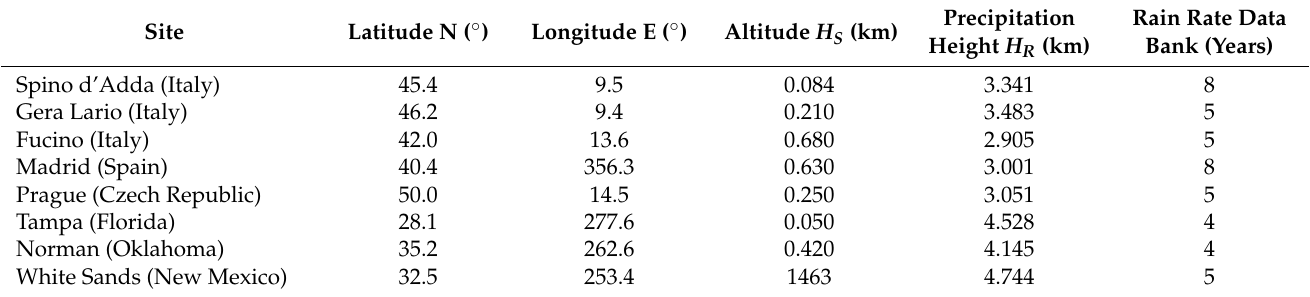
Table 1. Geographical coordinates, altitude (km), rain height H R (km), and number of years of continuous rain rate measurements at the indicated